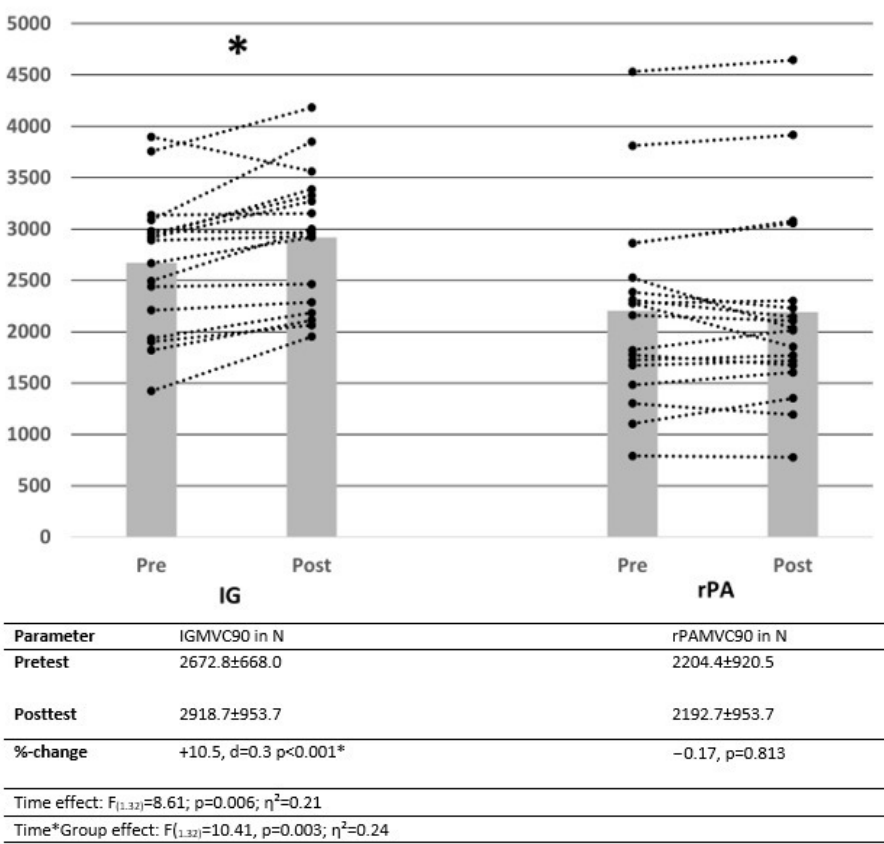
Figure 3. Change in mean values and individual cases of maximal voluntary contraction of control and intervention groups over time. Data presented as means ± SD. IG = intervention group, rPA = reduced physical activity group, MVC90 = maximal voluntary contraction in the plantar flexors with 90° knee joint angle, * = significantly different from pre-test to post-test.